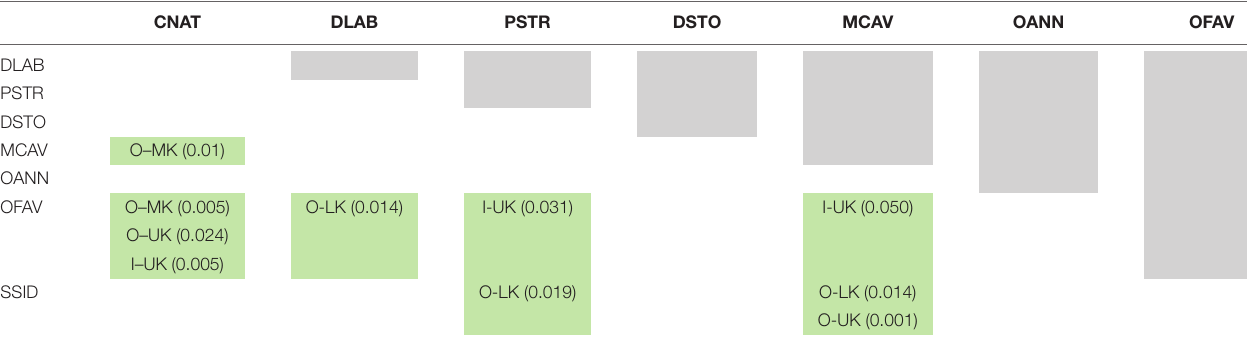
Regions are Offshore (O-) and Inshore (I-) as well as upper Keys (UK), middle Keys (MK), and lower Keys (LK). Orbicella faveolata had lower probability of being NAD than six other species/habitat combinations. Siderastrea siderea had a lower probability than three other species/habitat combinations. And Colpophyllia natans had a lower probability than one other species/habitat